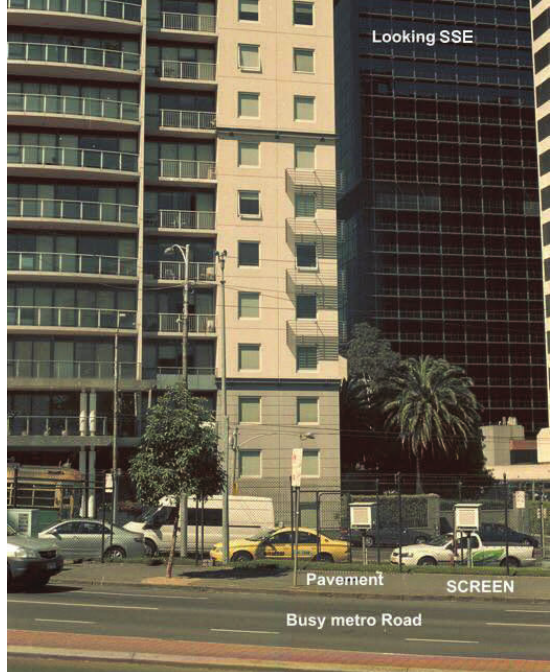
Figure 6. Melbourne regional office temperature measure- ment (from